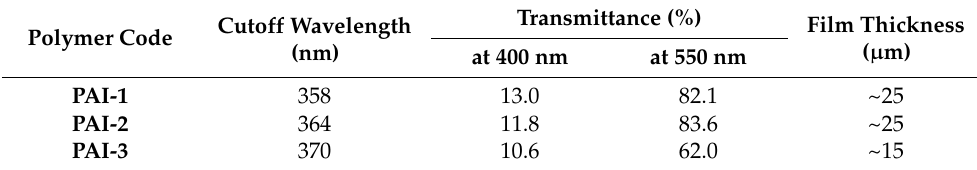
Table 3. Optical properties of the PAIs.